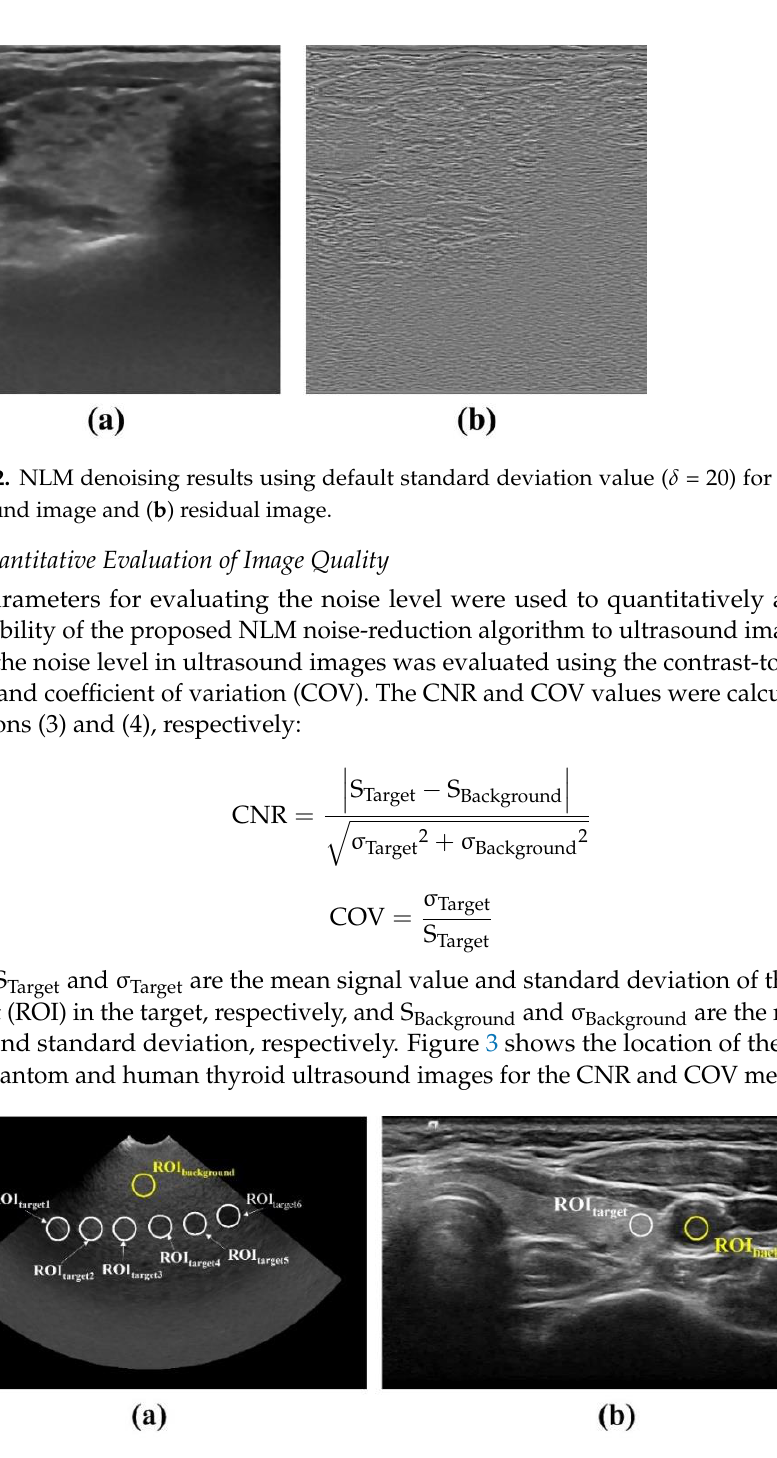
Figure 3. ROI setup for quantitative evaluation of ultrasound images: ( a ) ATS phantom and ( b ) human thyroid. In the ATS phantom image, the average values derived from six areas where gray-scale and dynamic range can be measured were used.